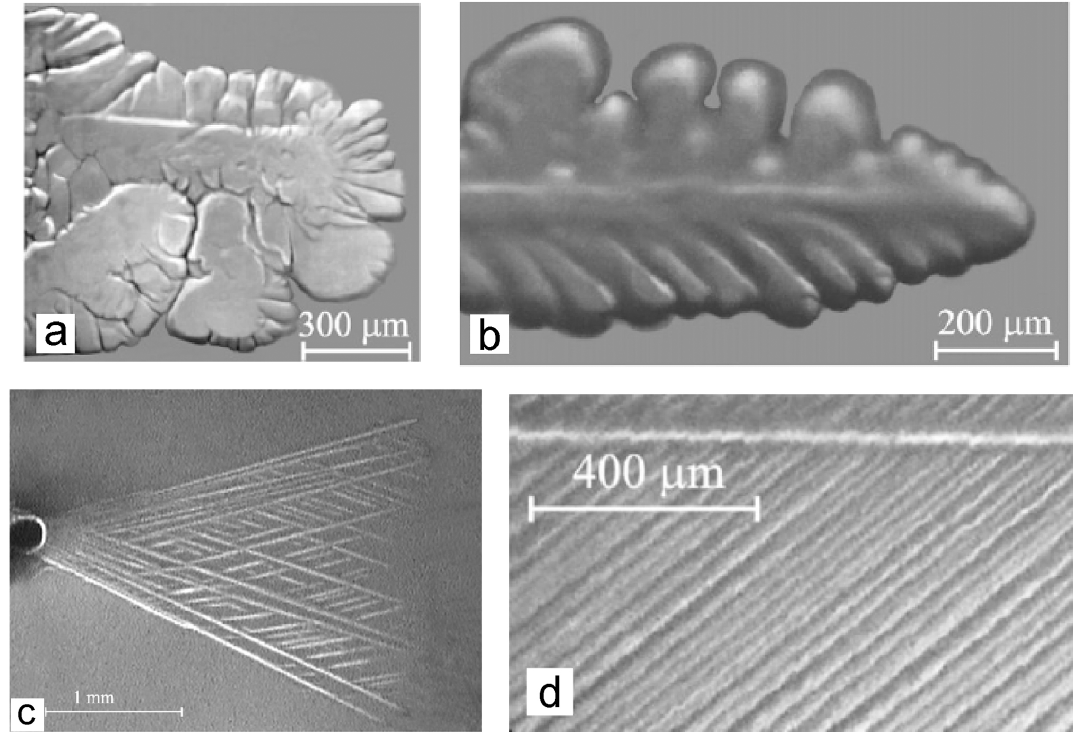
Figure 4. The morphology of ice crystal habits freely growing in pure water, supercooling at (a) (cid:49)T = 0 . 3 ◦ C, dense brunching structure; (b) (cid:49)T = 1 . 5 ◦ C, developed dendrite; (c) (cid:49)T = 4 . 1 ◦ C, needle-like crystals; (d) (cid:49)T = 14 . 5 ◦ C, compact needle mesh (adapted from Shibkov et al., 2003).